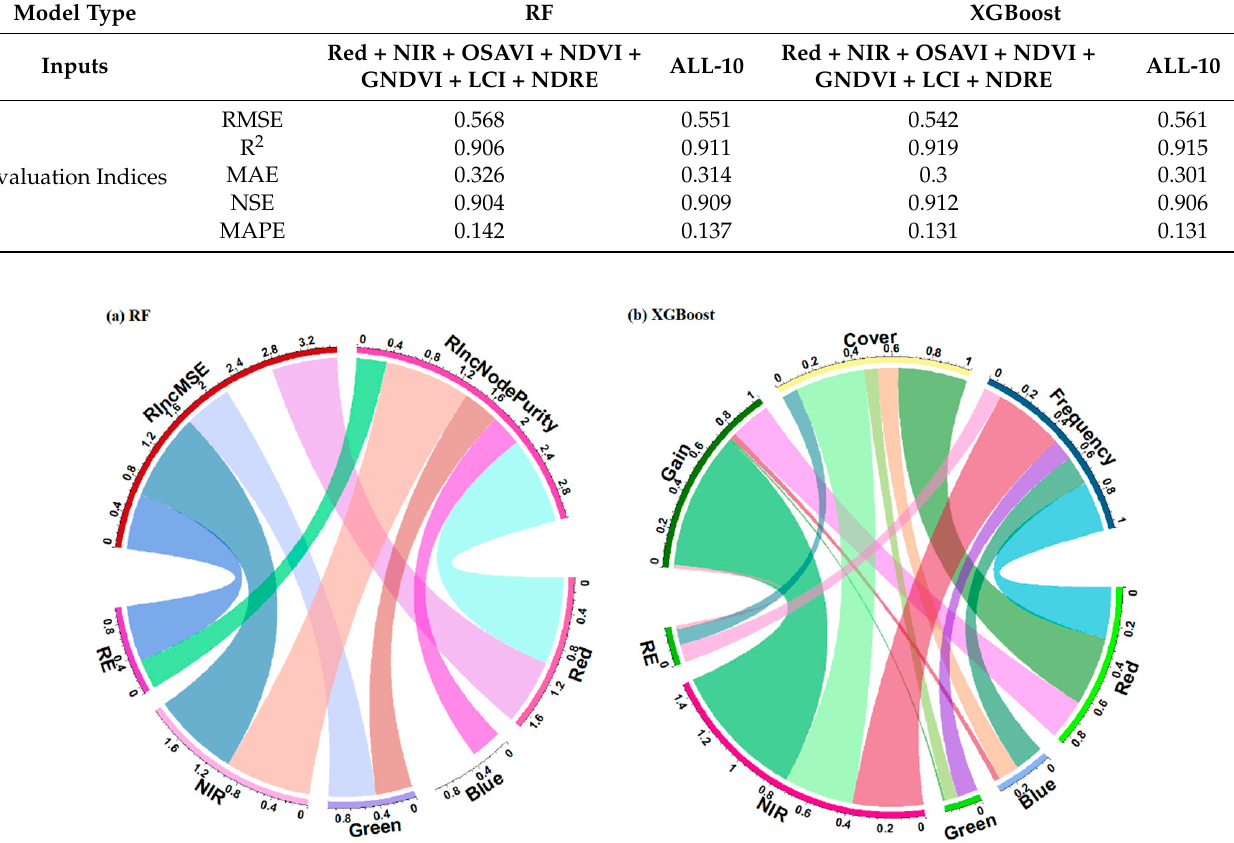
Figure 7. Important feature selection analysis with multispectral bands (B) as input variables by random forest model (RF, a ) and Extreme Gradient Boosting model (XGBoost, b ). IncMSE is the order of increase in mean square error, and IncNodePurity is the increase in node purity.